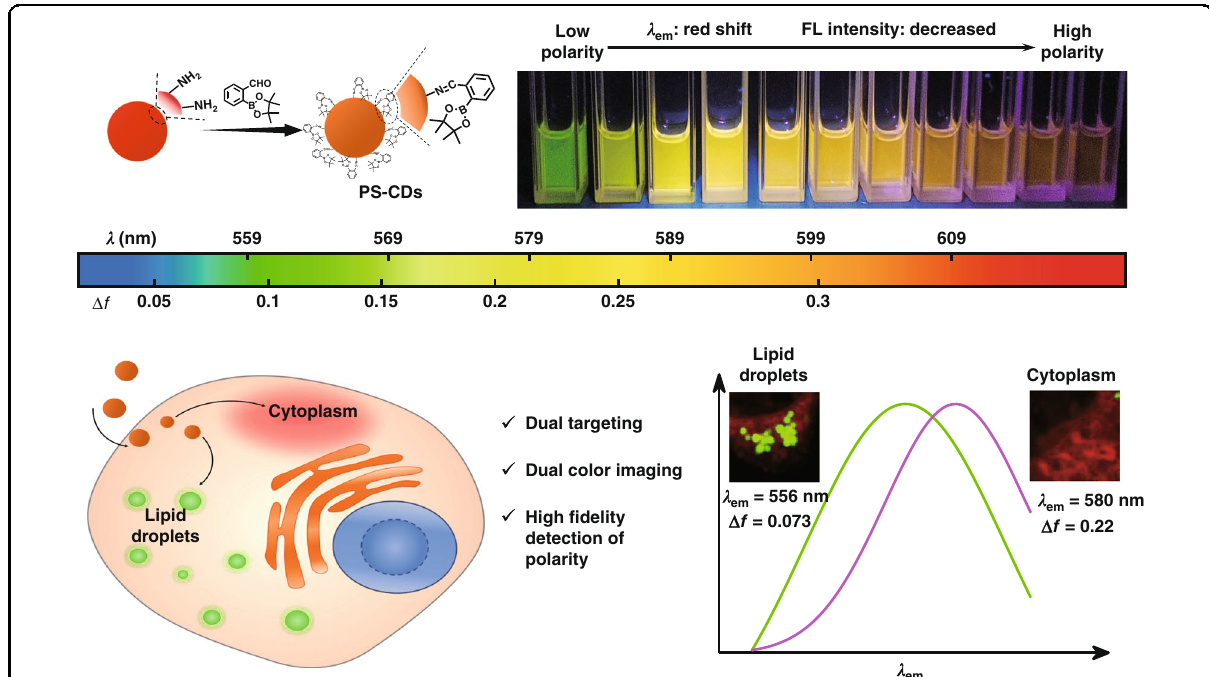
Fig. 1 Schematic representation of experiments. Schematic representation of the lipid droplets and cytoplasm imaging with different emission windows and high- fi delity detection of polarity by in situ emission